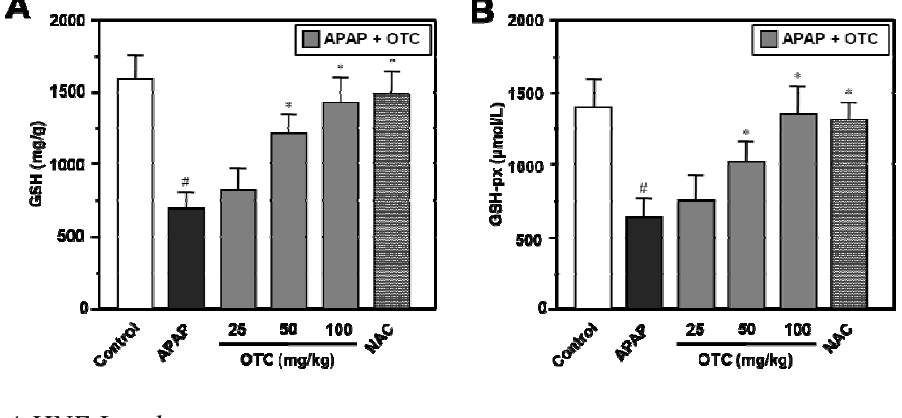
Figure 2. OTC administration elevates GSH and GSH-px levels in APAP-induced hepatotoxicity. Mice were orally treated with saline or OTC or NAC 2 h before injection of 300 mg/kg APAP. Twelve h after APAP injection, liver tissues were collected for measurement of GSH and glutathione peroxidase. GSH ( A ) and glutathione-px ( B ) levels are ameliorated in a dose dependent manner of OTC in APAP-overdose mice. Data represent mean ± SE of n = 6 animals per group. # p < 0.01 vs . control group, * p < 0.05 vs . APAP alone group.